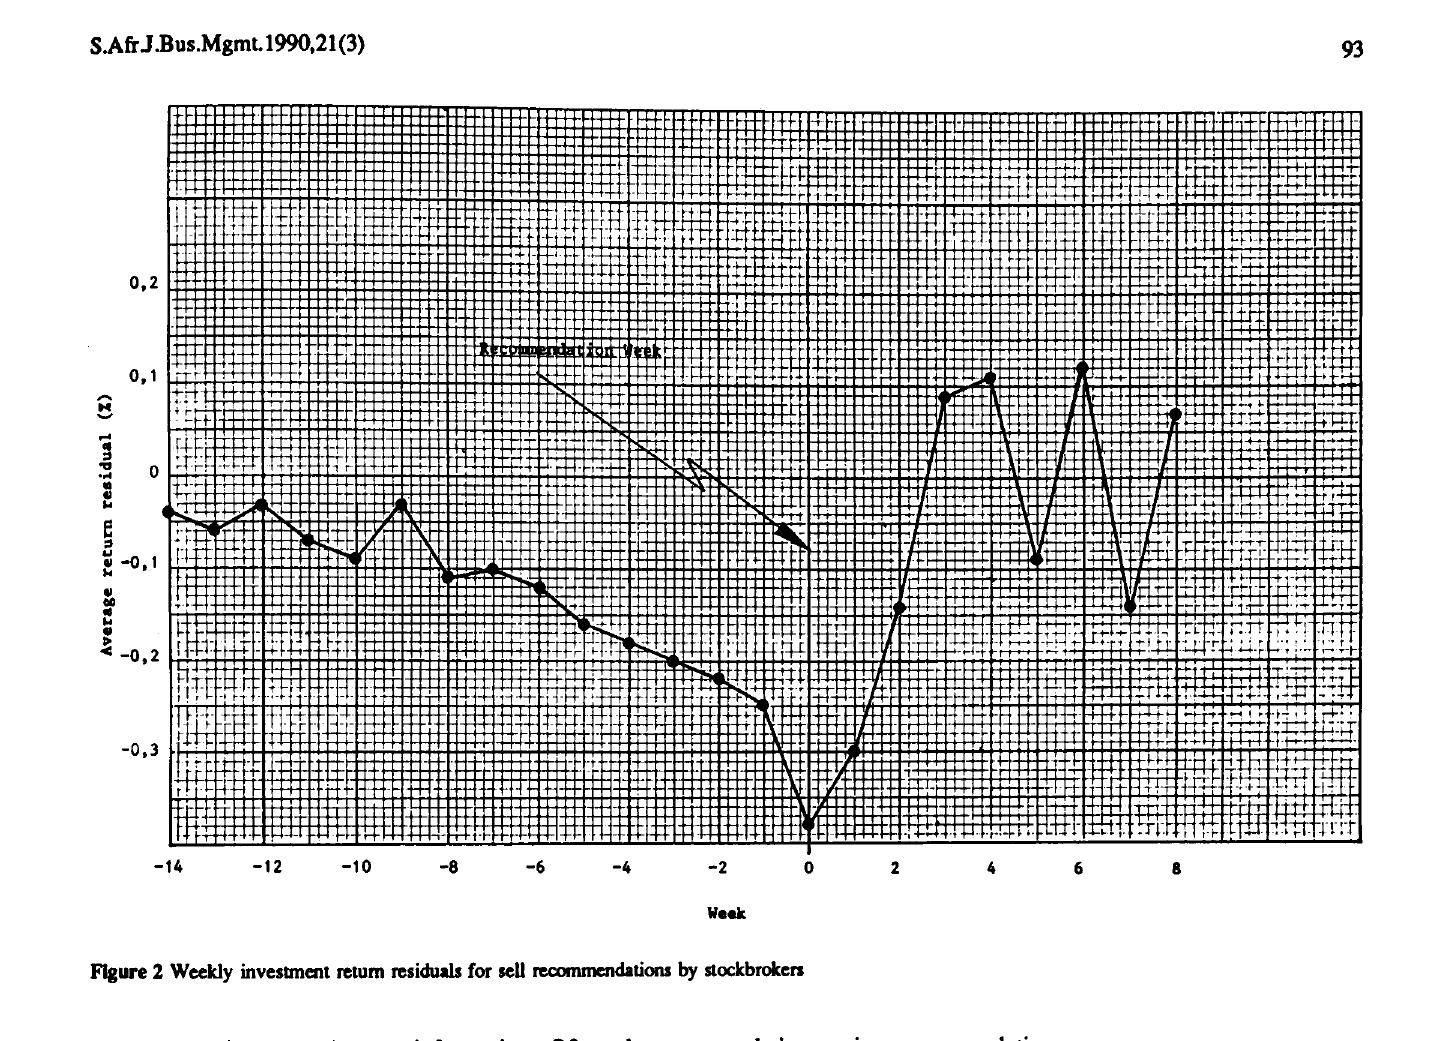
Figure 2 Weekly investment return residuals for sell recommendations by